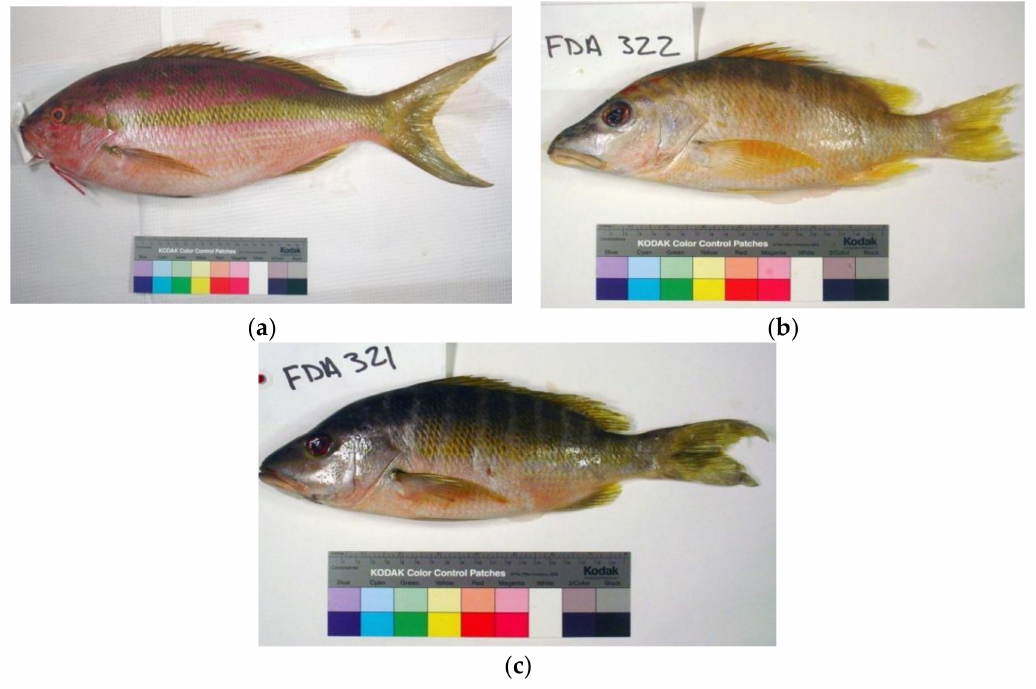
Figure 1. ( a ) Ocyurus chrysurus (Yellowtail snapper) (FDA51 / USNM394166), ( b ) Lutjanus apodus (Schoolmaster snapper) (FDA322 / USNM444948), ( c ) Hybrid (FDA321 / USNM444947) between: O. chrysurus (male) + L. apodus